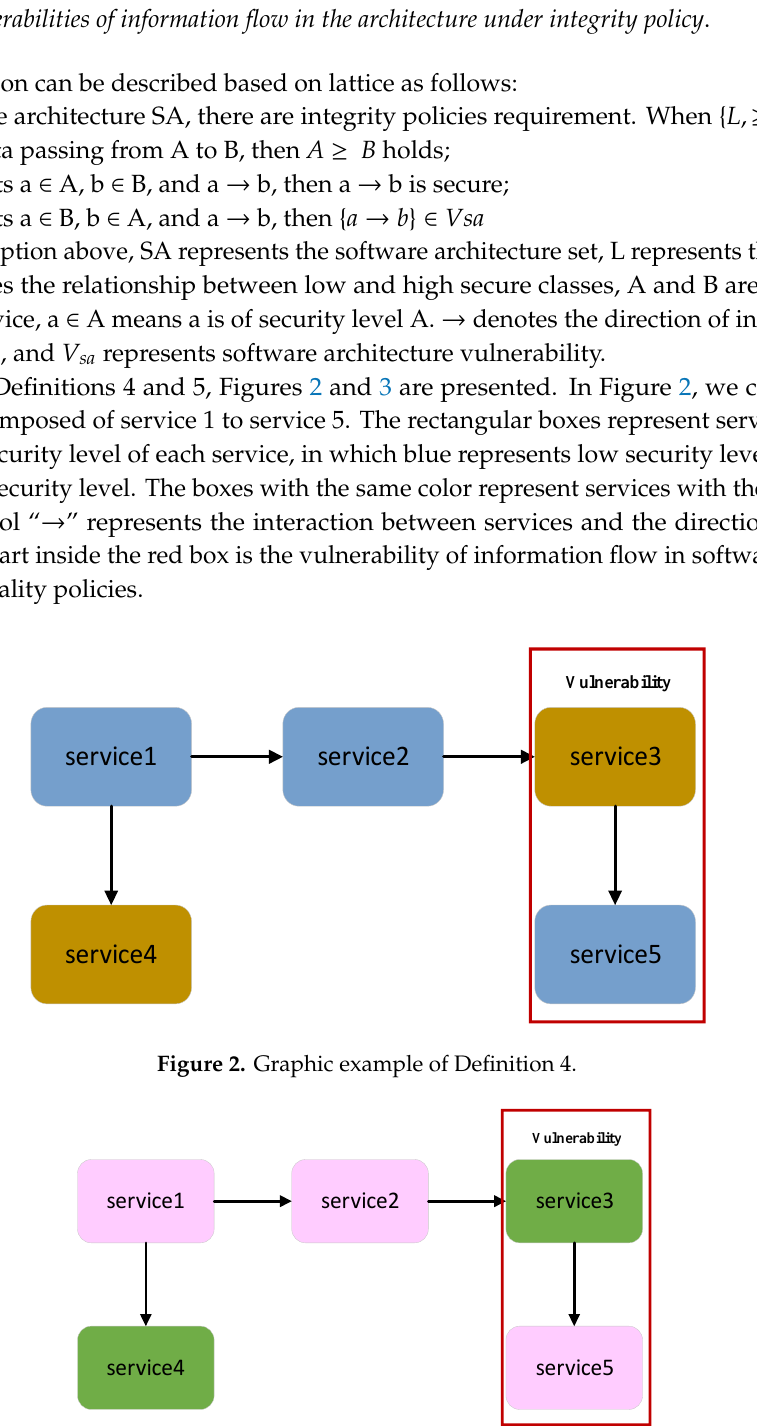
Figure 3. Graphic example of Definition 5. 3.3. Security Policies of Information Flow in Architecture